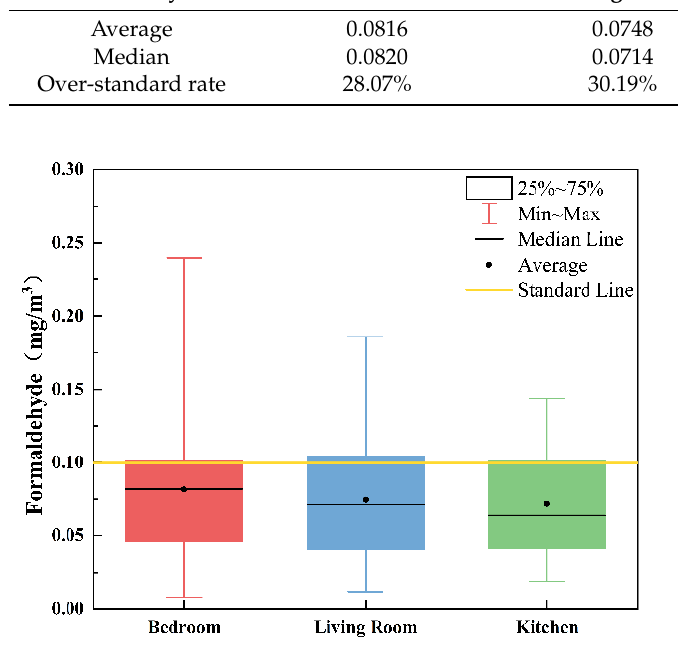
Figure 2. Indoor formaldehyde concentration in 60 households in Liaoning.